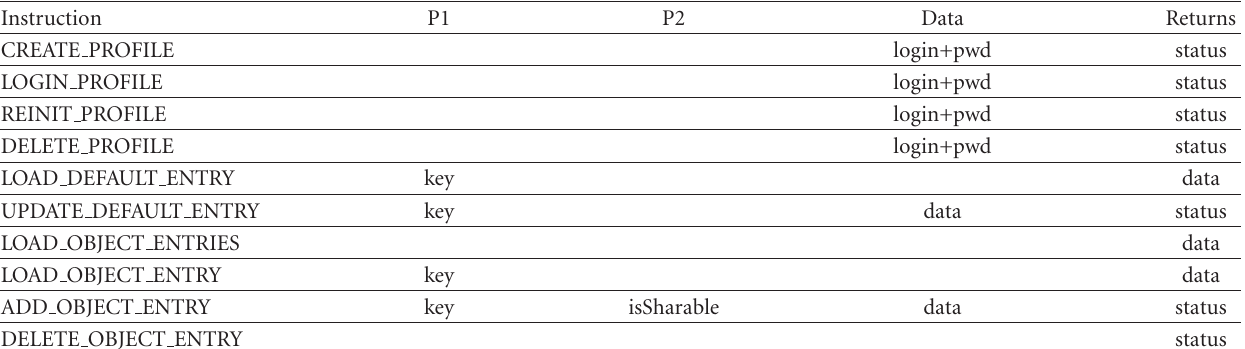
Table 1: APDU instructions used in